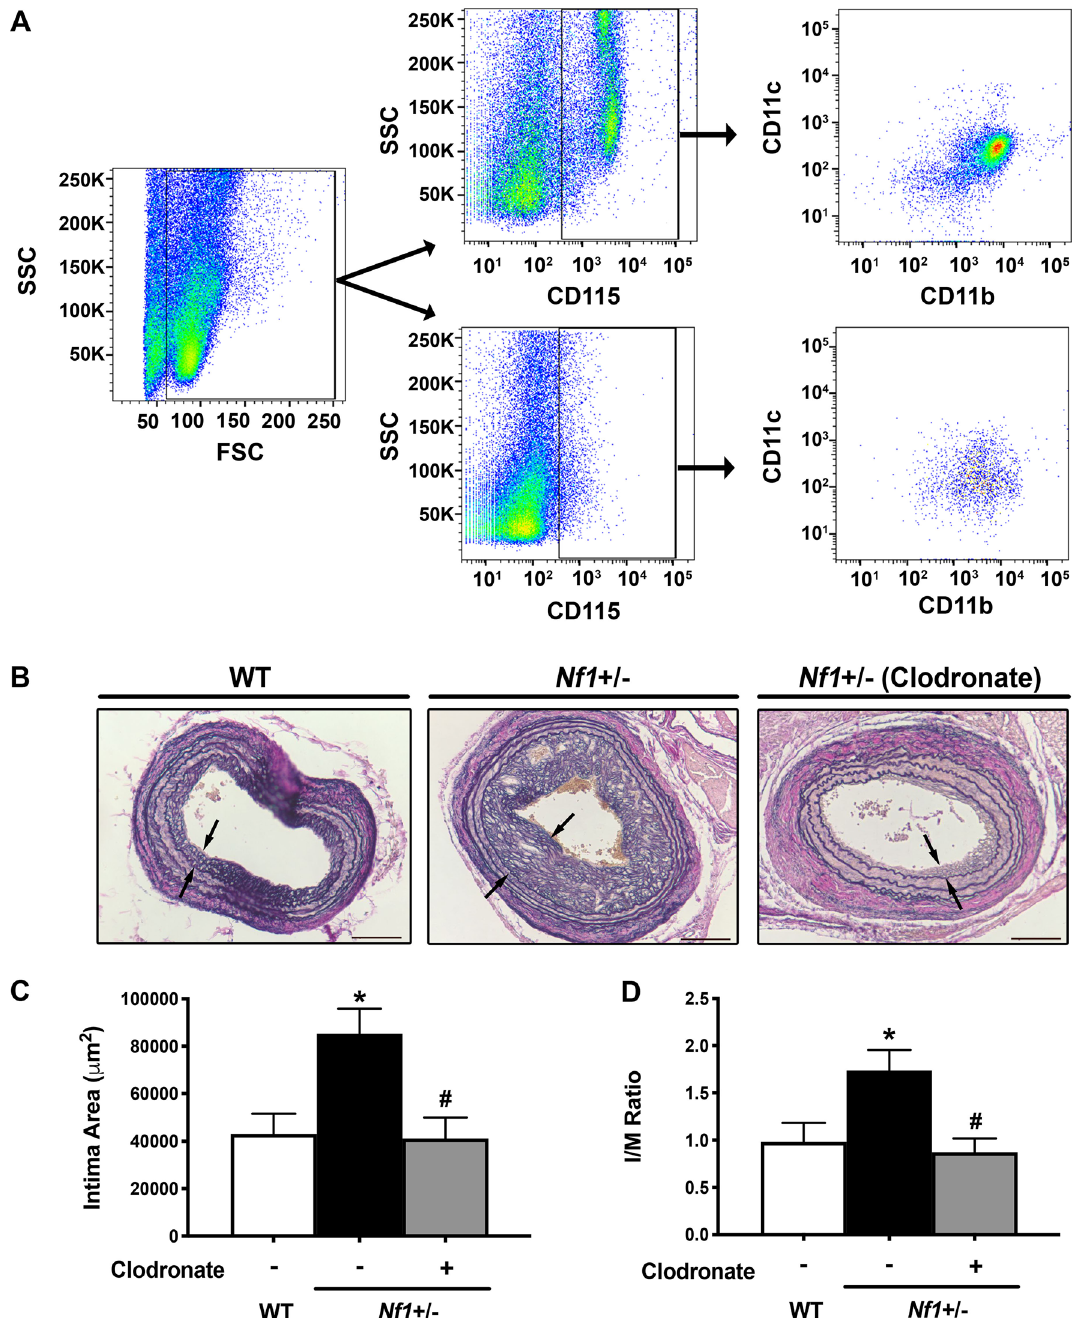
Figure 5. Monocyte/macrophage depletion decreases neointima size in Nf1 +/– mice. ( A ) Representative gating strategy demonstrating depletion of CD115+ /CD11+ /CD11b+ monocytes. ( B ) Van Gieson-stained images of injured carotid arteries from WT and Nf1 +/– mice provided liposomal clodronate or empty liposomes. Black arrows indicate neointima boundary. Scale bars: 100 μm. ( C and D ). Data represent mean intima area (μm 2 ) ( C ) and I/M ratio ( D ) ± SEM, n = 8–11 per group. * P < 0.05 for WT versus Nf1 +/– mice. # P < 0.05 for Nf1 +/– mice receiving clodronate versus Nf1 +/– mice receiving empty liposomes. Analysis by 1-way